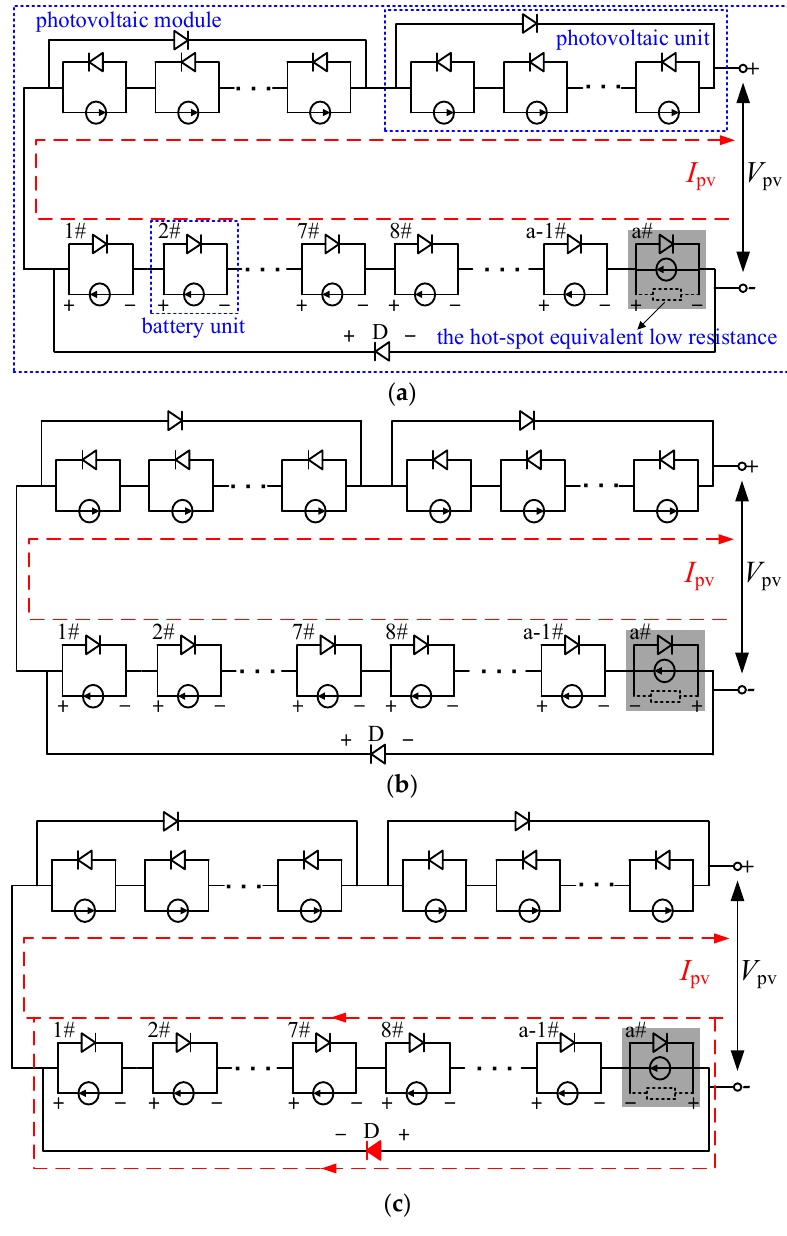
Figure 5. Schematic diagrams of photovoltaic module with low resistance hot-spot fault showing three states: ( a ) state I; ( b ) state II; and ( c ) state III.